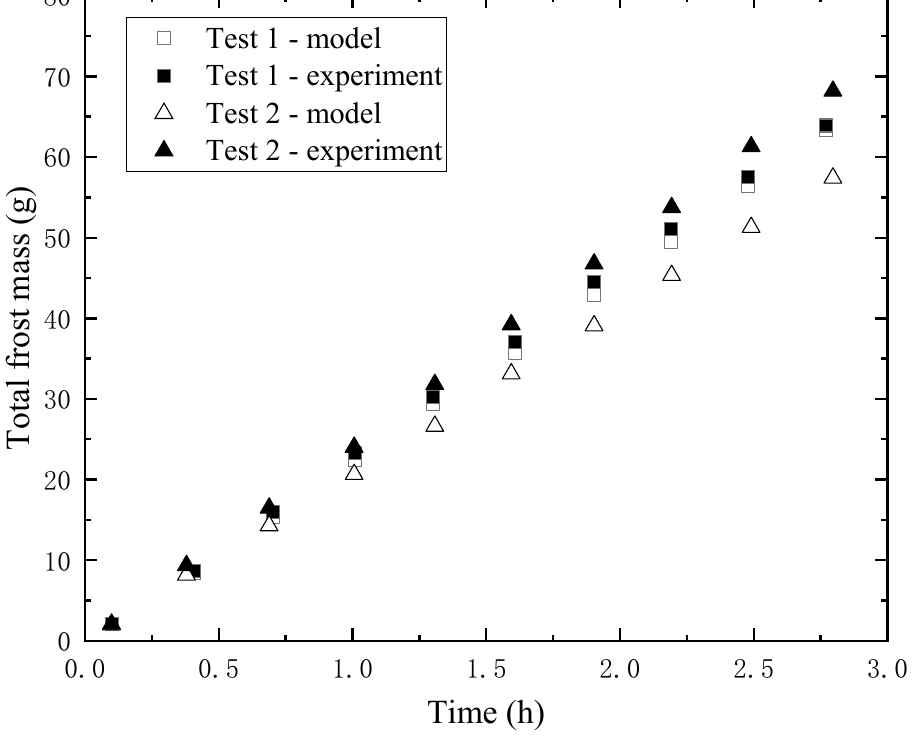
Figure 4. Total frost mass in the model and experiment [21]. Table 3. The test conditions of return air and evaporating temperature.